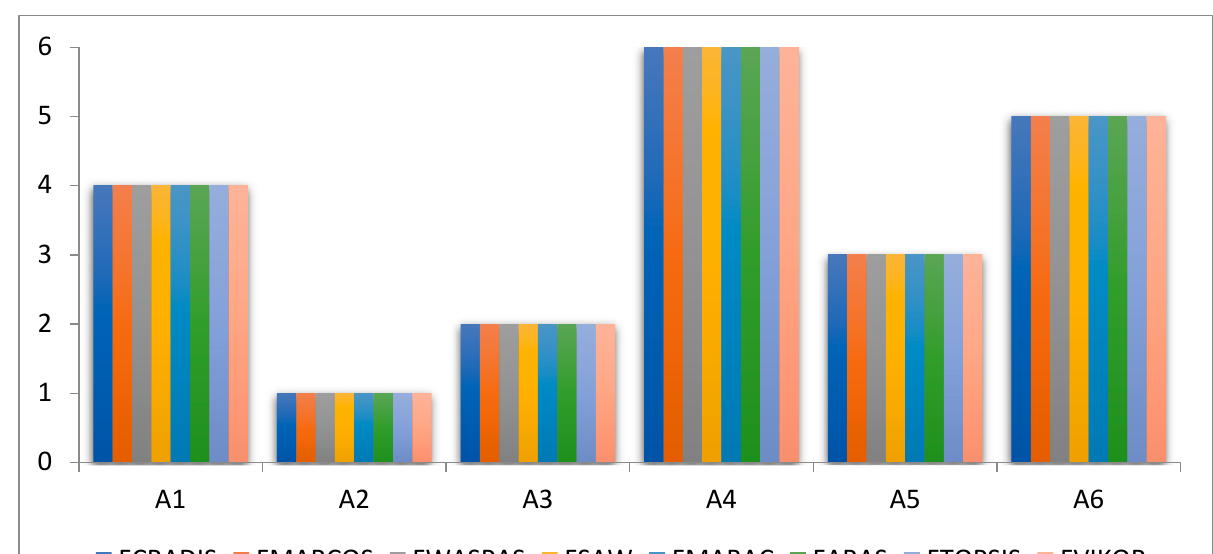
Figure 1. Validation of alternative ranking results.